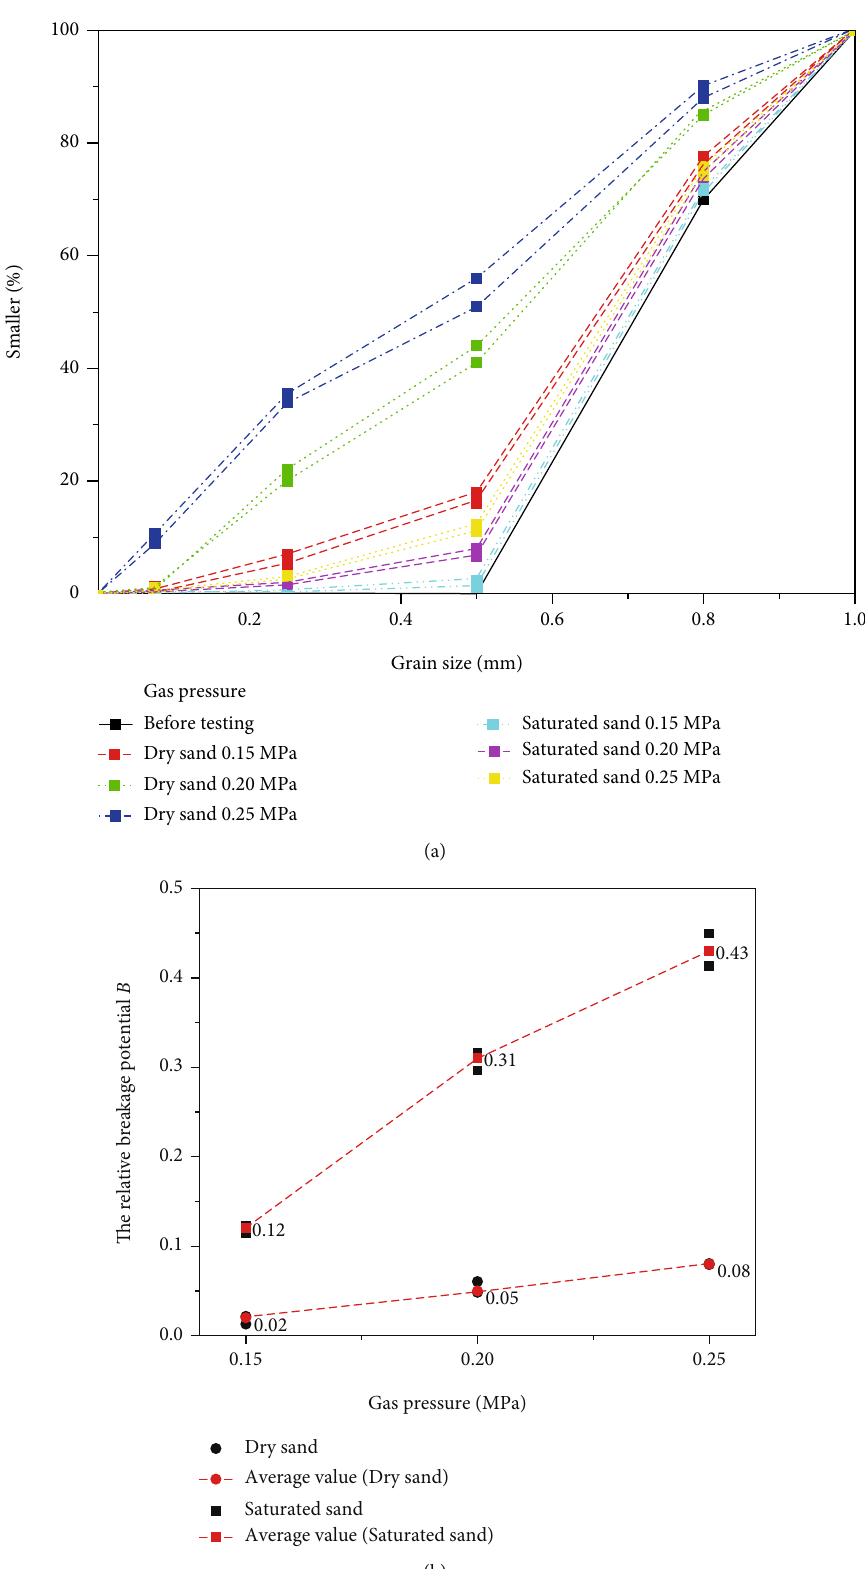
Figure 8: (a) Particle size distribution curves of D-1 ~ S-6 specimens after impact. (b) Variation diagram of average relative breakage potential under di ff erent working